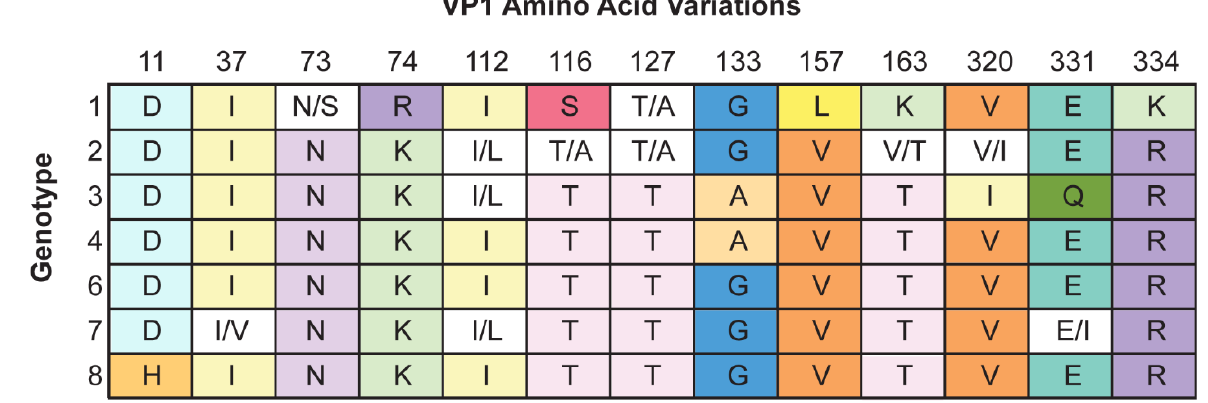
Figure 2. VP1 amino acid variations between genotypes. Genotypes (rows) and key VP1 sequence locations (columns, top) and associated amino acid differences are noted. One color was assigned to each amino acid. White signifies multiple possibilities.